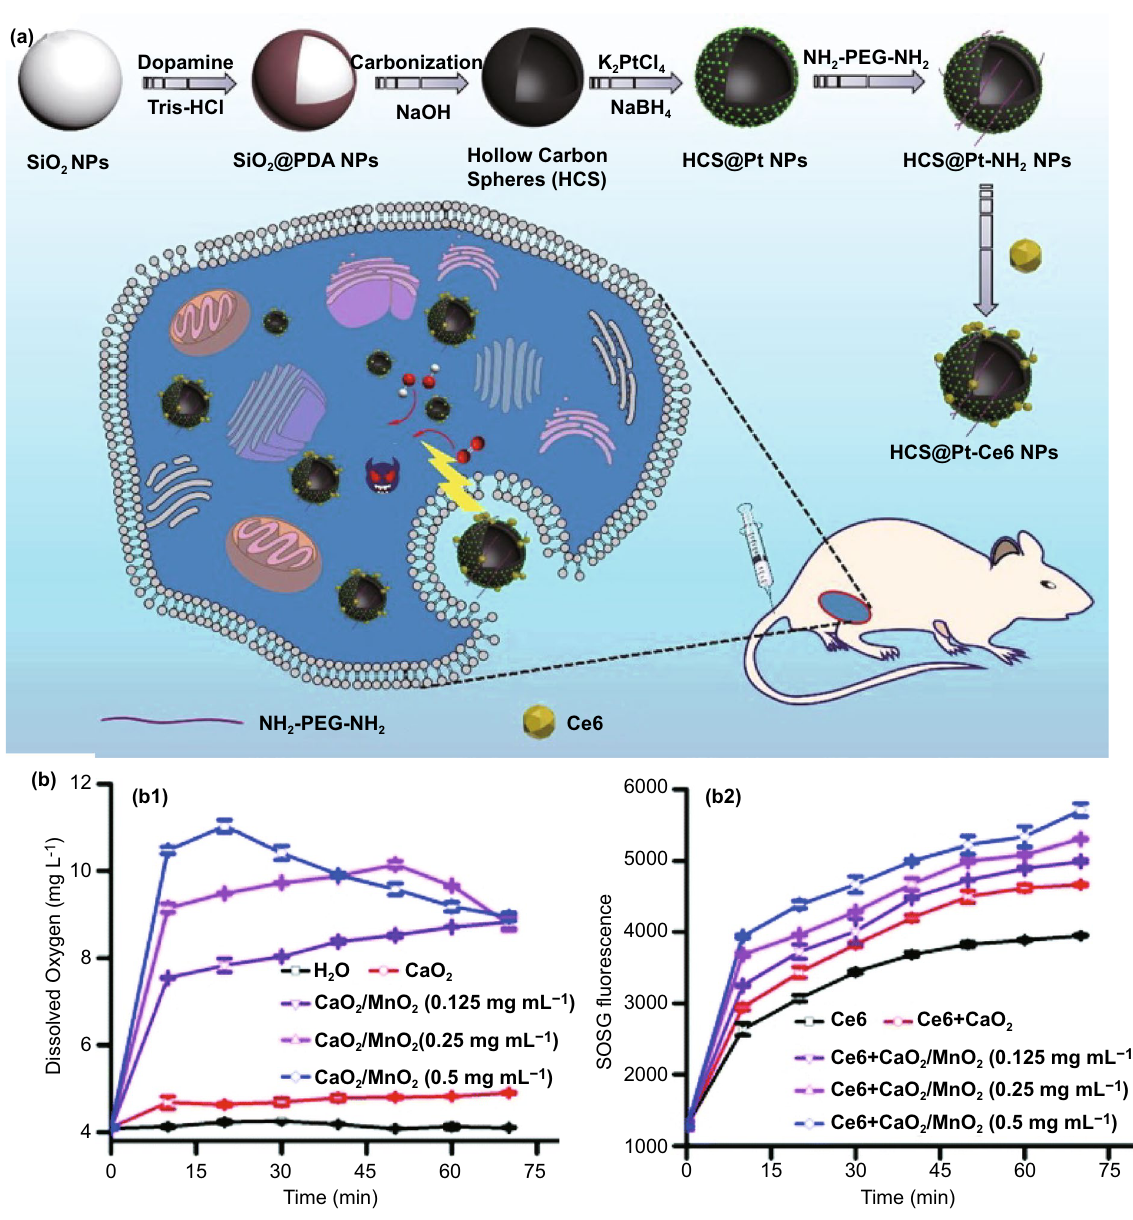
Fig. 11 a Synthesis progress of HCS@Pt-Ce6 NPs with multi-enzyme-like activity for PDT enhancement. The content of produced b 1 O 2 and b2 1 O 2 (via Ce6) with CaO 2 NPs at 0.5 mg mL −1 and MnO 2 NPs at different concentrations. Adapted from a Ref. [415], b Ref. [416] with per-